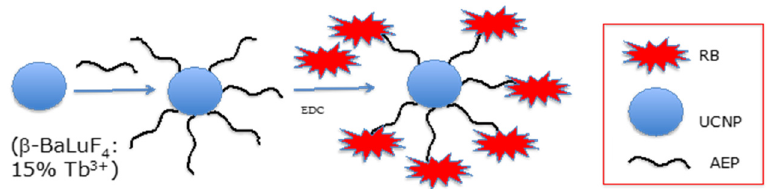
Figure 45. Preparation of XLNPs-RB. Adapted from Zhang et al. [112].